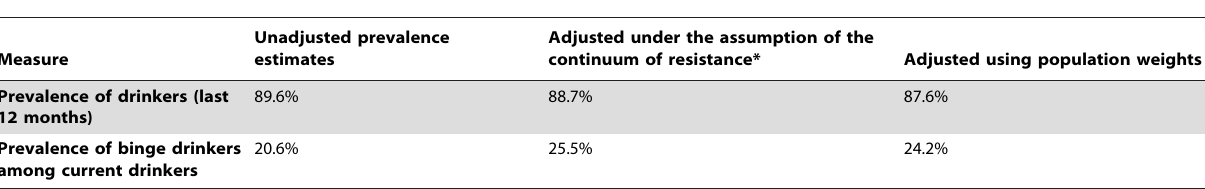
Table 3. Estimates of drinking and binge drinking prevalence in the GENACIS